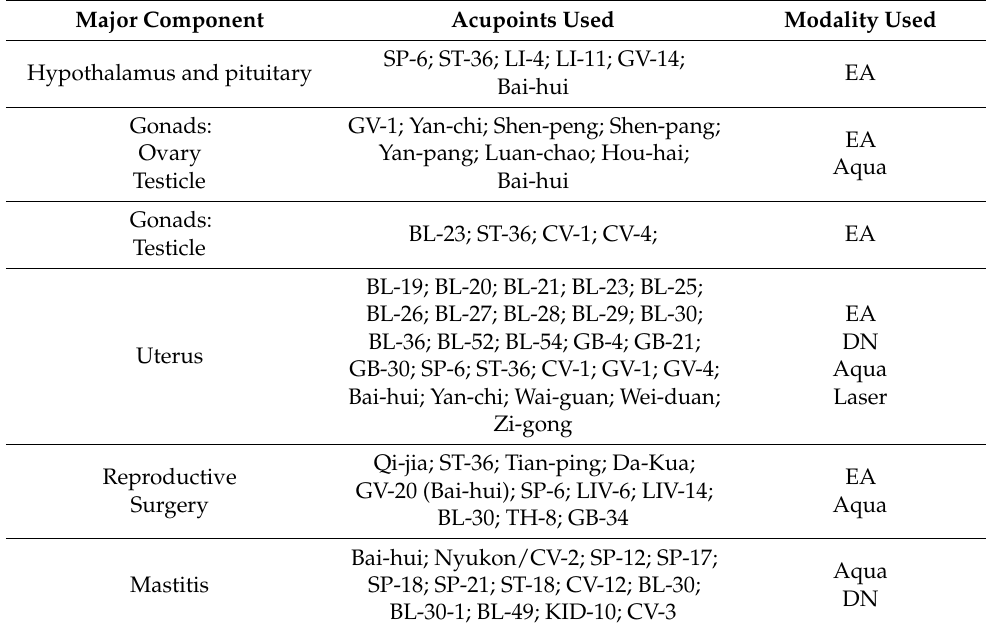
Table 1. Overview of acupuncture points and modalities utilized directed at each major component of the reproductive